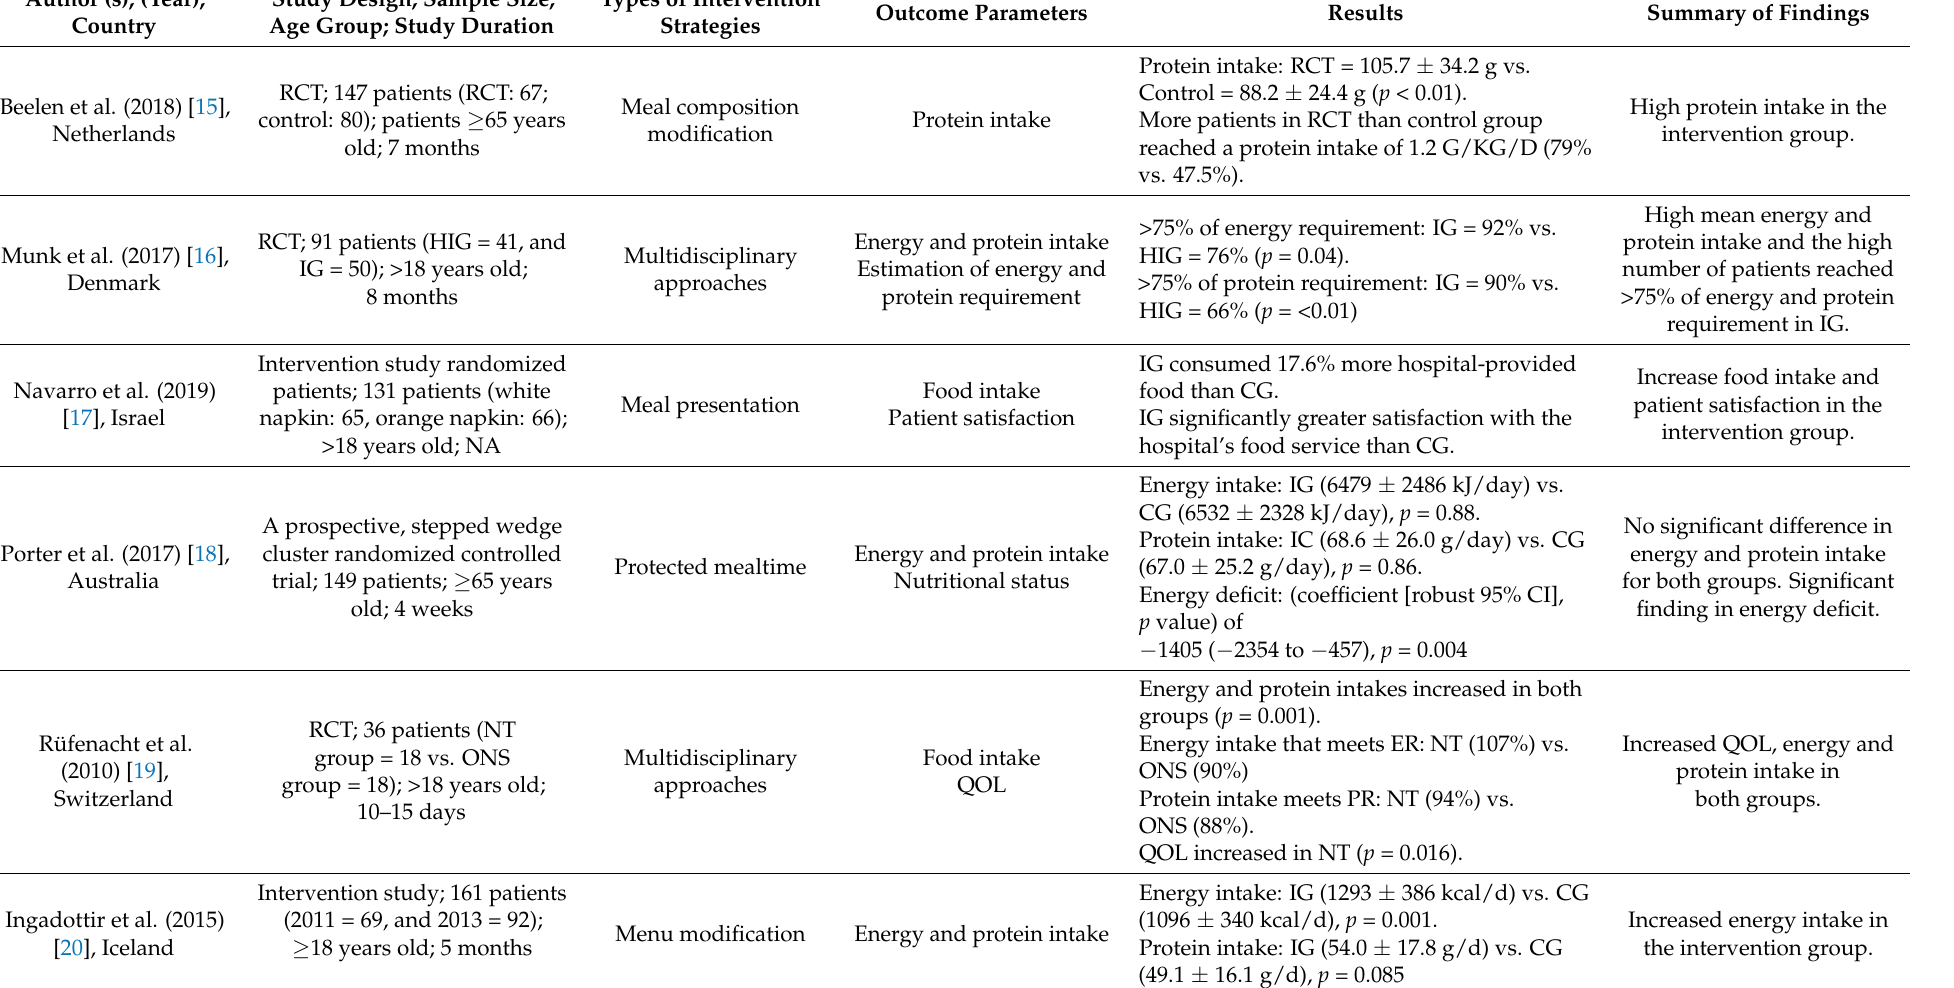
Table 1. Summary of individual studies related to the impact of hospital food service intervention strategies on inpatient’s food